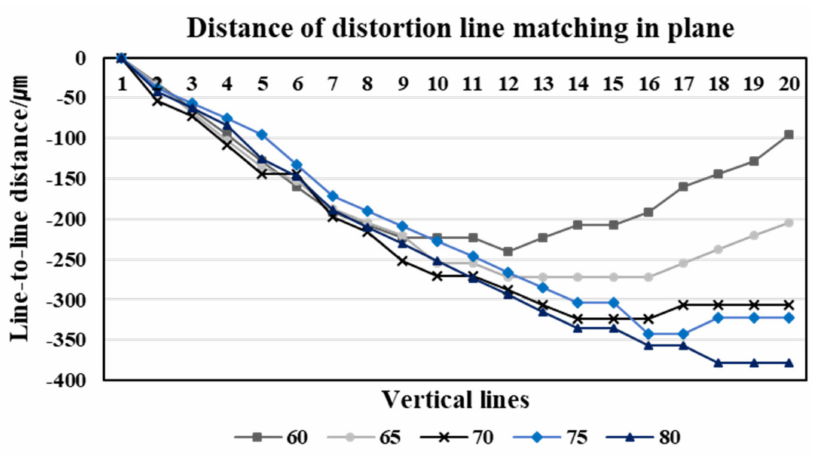
Figure 4. The stereo matching results of the distorted stereo image in a